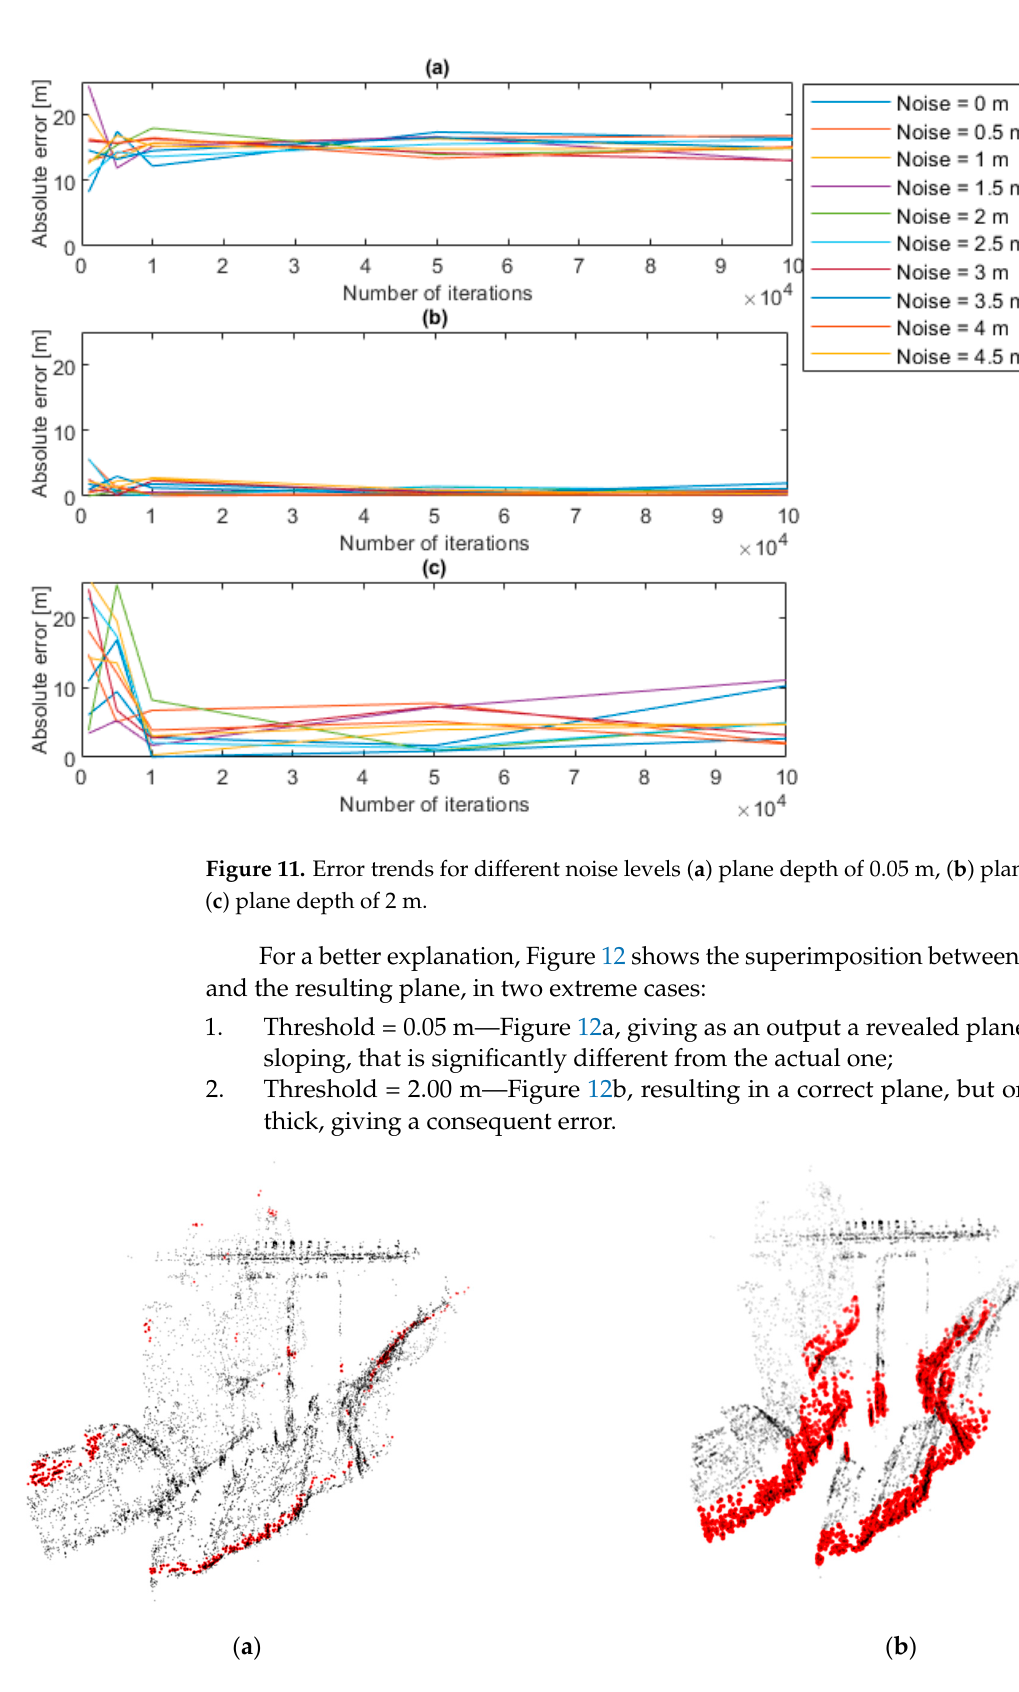
Figure 12. Plane resulting from two different thresholds (0.05 m ( a ) and 2.00 m ( b )).